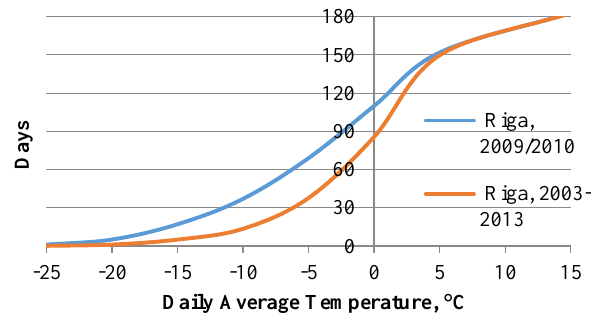
Fig. 2. Heating season climate in Riga for year 2009/2010 and from year 2003 to 2013. The results from winter season 2013/2014 were collected as well and are shown in Fig. 4. and Table II. It is visible that this season was warmer with an average temperature of +1.9 °C. In